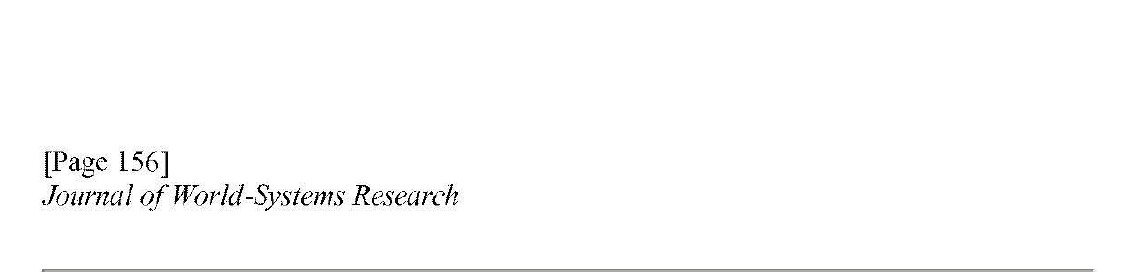
Table 5 - Comparison of Estimates of Unequal Exchange For For Estimate Es t i ma t e Year Uni t In current as a percent of analysis us dollars of GDP of GDP of LIC (a) of HIC (a) Amin 196 6 deve lo p i ng 22 billion -1 5':: + 1. 5,); countries Kohler 1993 non-OECD 1. 06 tr illion - 21-e +5 . 7't